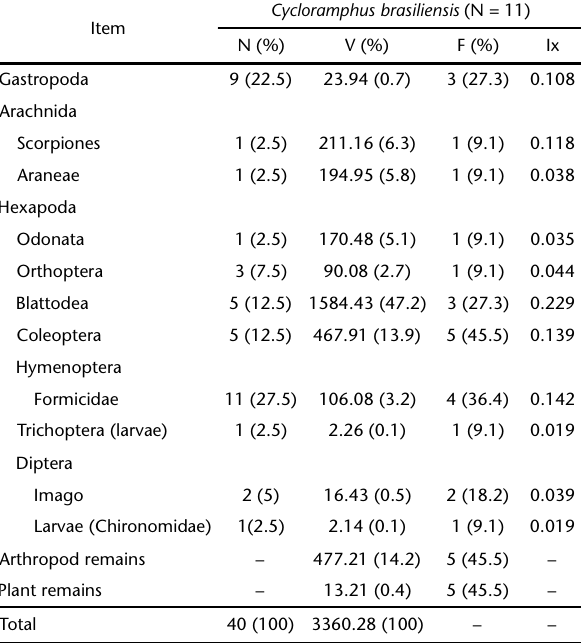
Table I. Diet composition of Cycloramphus brasiliensis (N = 11) in the Atlantic Rainforest in the state of Rio de Janeiro, southeastern Brazil, containing the number (N) of prey consumed, volume (V, in mm 3 ) of prey, frequency (F) of occurrence of each category of prey (percentages in parentheses), and Index of Importance Value